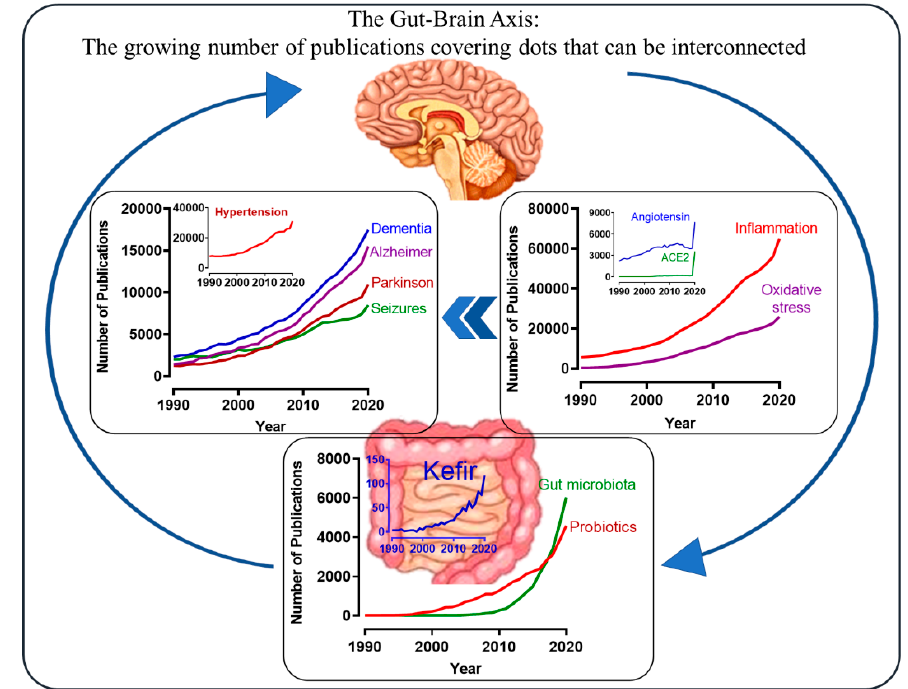
Figure 1. Schematic illustration and graphs constructed by plotting the number of papers published per year in indexed journals listed on the PubMed platform. The arrows indicate the multifactorial and interactive connections, including inflammation, oxidative stress, hypertension and angiotensin/ACE2. We interpreted the sharp increase in the number of published papers relating to angiotensin/ACE2 in 2020 as being due to its role in COVID-19. The bottom panel shows a large jump in the number of papers in “microbiota” (~26,000), demonstrating the current relevance of therapies based on the use of probiotics and that kefir shows a similar profile. ACE2 : Angiotensin-Converting Enzyme type 2. The above diagram was created by one of the coauthors of this review, a 76-year-old researcher suffering from PD for 12 years.